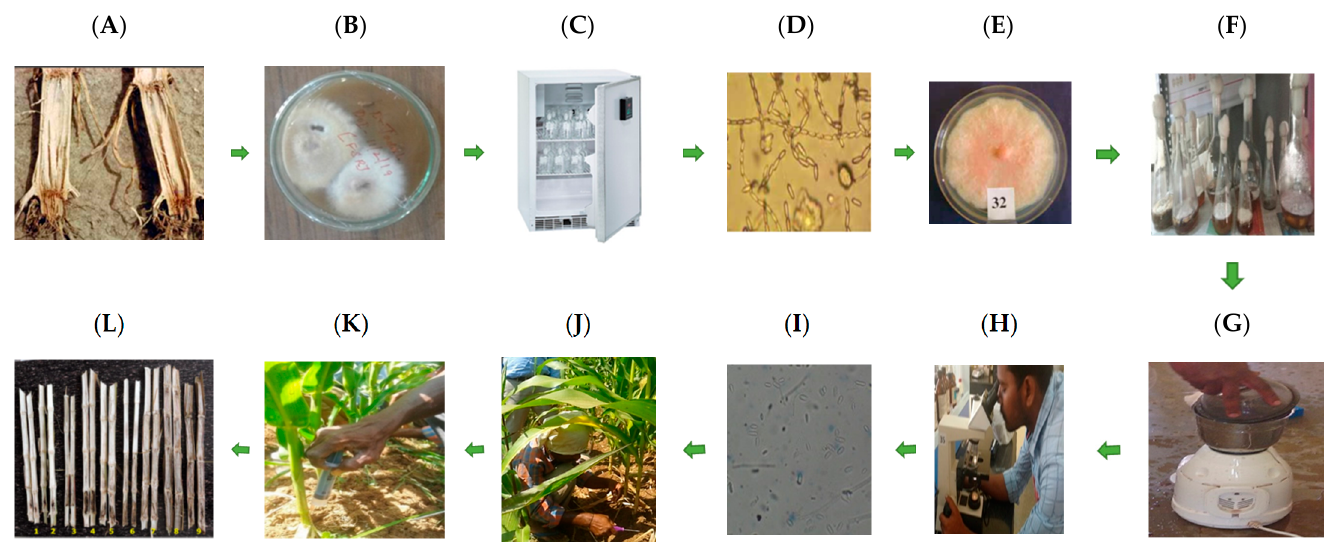
Figure 2. Isolation, mass multiplication, and artificial inoculation of Fusarium verticilloides pathogen ( A ), FSR infected stalks were cut into small pieces, surface sterilized with sodium hypochloride and washed with distilled water ( B ), Air dried and transferred to PDA medium ( C ), Kept in BOD incubator for 5 days ( D ), The pathogen colonies examined for characters typical of F. verticilloides ( E ), Pure culture of FSR ( F ), Mycelia were mass multiplied in the conical flasks containing sterile PDB ( G ), Mycelial mat on 15th day was grounded and filtered ( H ), Pathogen spore count using Haemocytometer ( I ), The spore suspension was adjusted to 1 × 10 6 spores per ml ( J ), Making 2 cm hole at 2nd internode of 45-50 days old plant with jabber ( K ), Injection of 1 × 10 6 conidia/ml at 45 degree angle using syringe ( L ), Stalk were split opened 25 – 35 days after inoculation and evaluated using 1–9 disease rating scale.